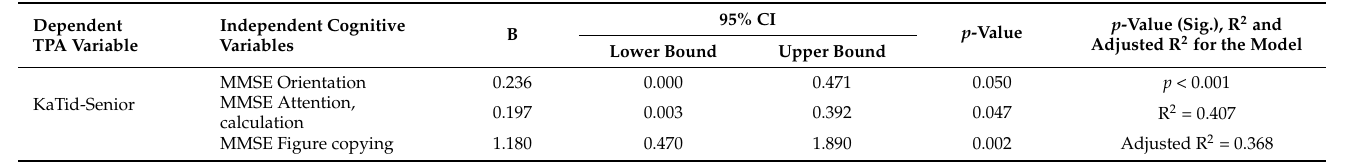
Table 3. Multiple linear regression model of time processing ability (KaTid-Senior) to orientation, attention and calculation, and figure copying (MMSE sub-items).